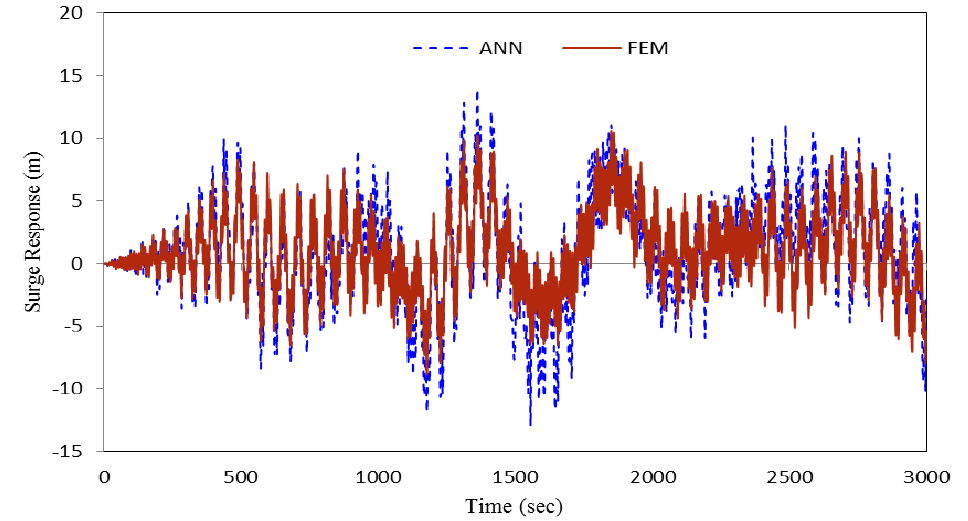
Figure 7. Surge response time history predicted for wave height of 9.65 m and wave period of 10.10